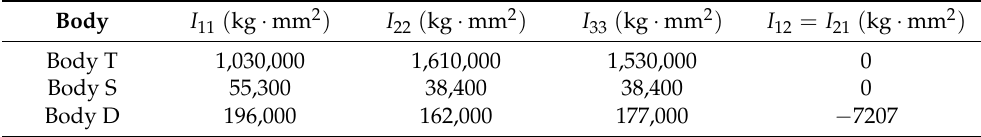
Table 3. Moments and products of inertia of the three